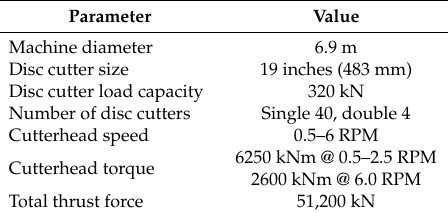
Table 3. TBM specifications.